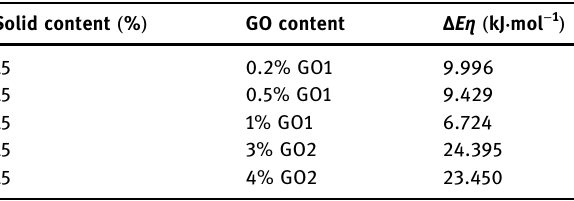
Figure 9: lg η ∼ γ 0.5 curves of PAN/GO/DMSO solutions with di ff erent contents. Table 4: Structural viscosity index of PAN/GO1/DMSO blend solu - tions with di ff erent GO